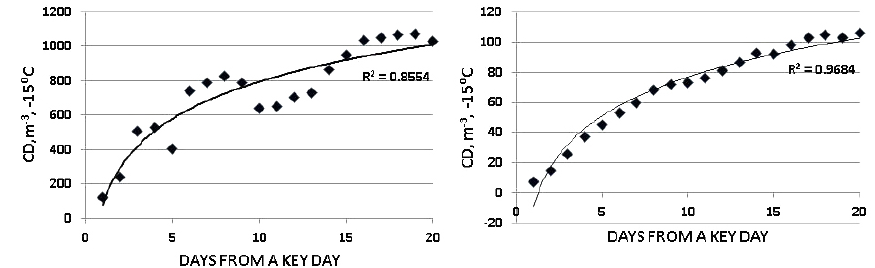
Figure 3. CD in IN as a function of days after a key day for (left) Group 2, Table 1 sites, (right) Group 3, Table 1 sites.